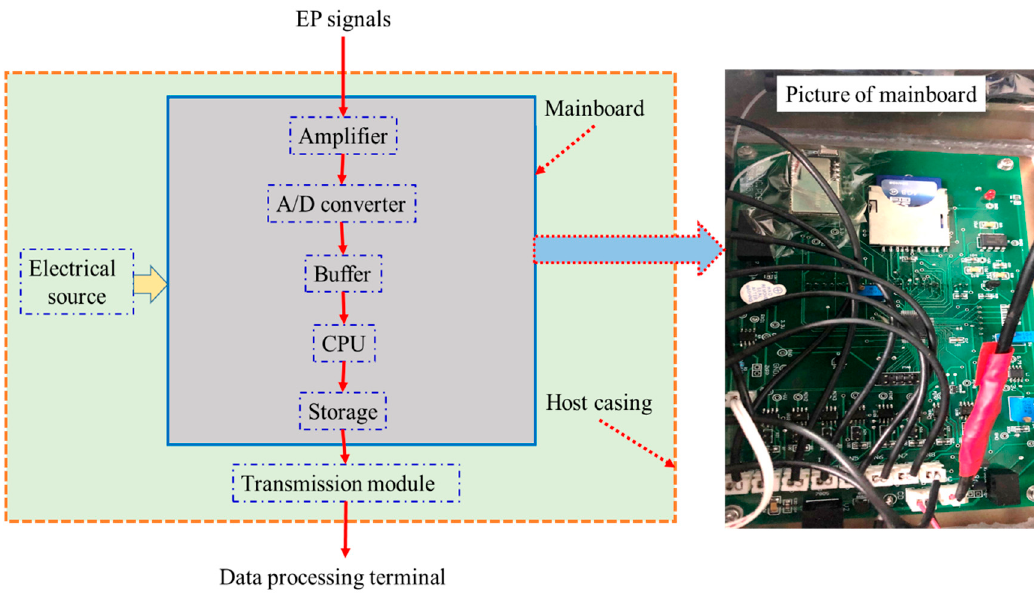
Figure 2. Schematic diagram of EP signal processing.